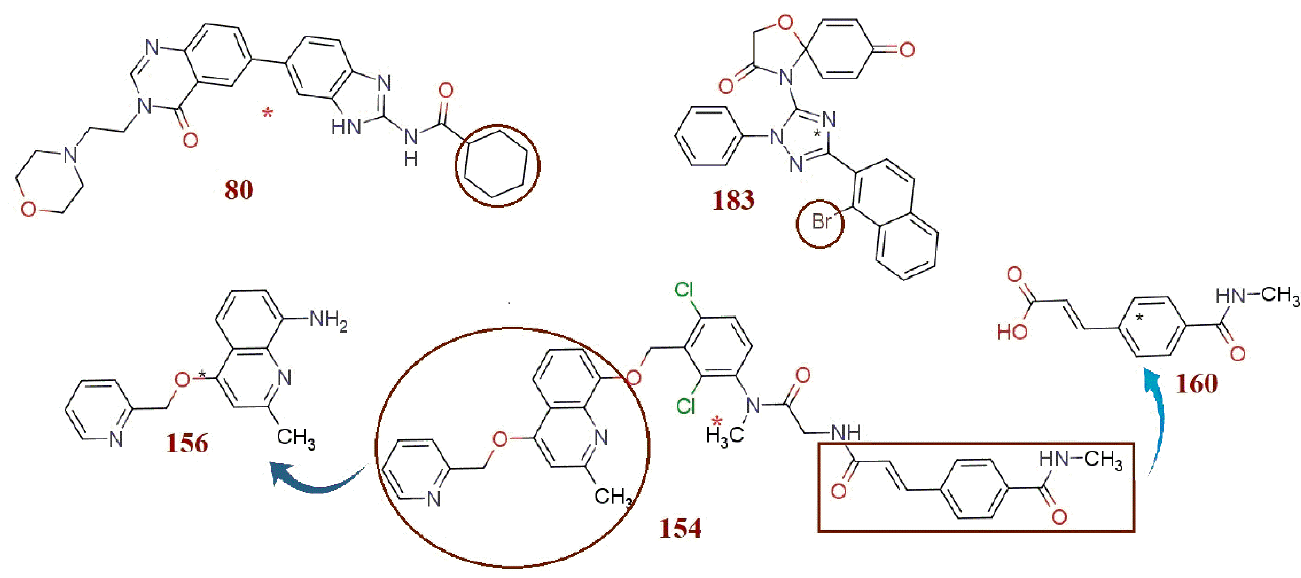
Figure 7. Representation and illustration of outliers.